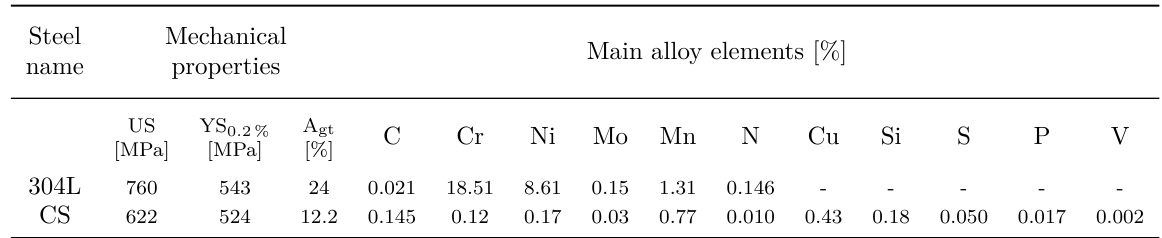
Table 1. Mechanical properties (US = ultimate strength; YS 0 . 2% = yield strength at 0.2% of deformation; A gt = total elongation at maximum force) and main alloy elements of the stainless steel bars and carbon steel bars.